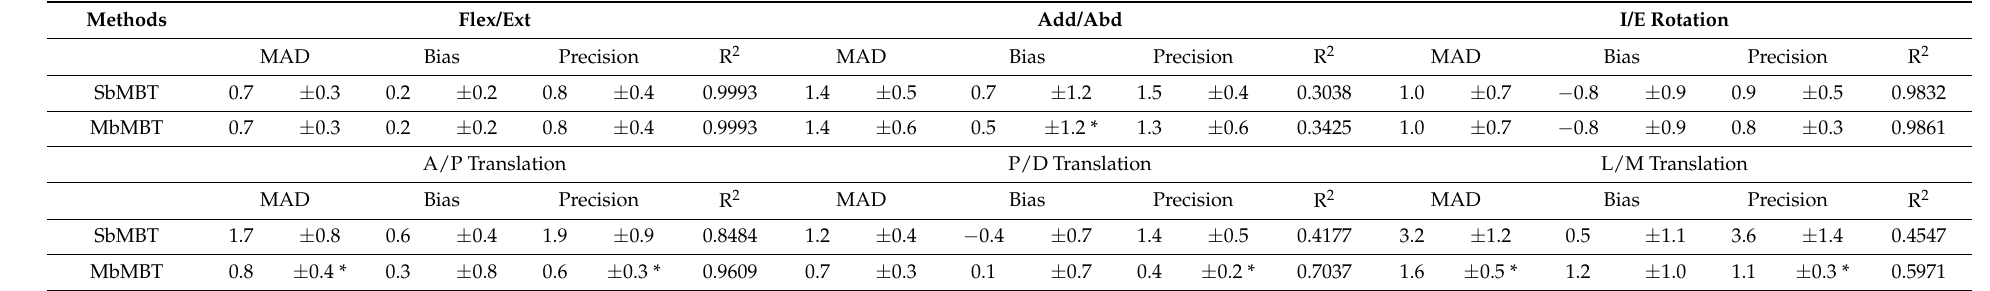
Table 1. The means ± standard deviations of the mean absolute differences (MAD), bias and precision values over all subjects for six degree-of-freedom kinematics of the knee joint during isolated flexion. The coefficient of determination values (R 2 ) were obtained from linear regression analysis on the knee kinematics derived from the SbMBT and MbMBT methods against reference values. Asterisks indicate significant differences in the variables between the MbMBT and SbMBT.